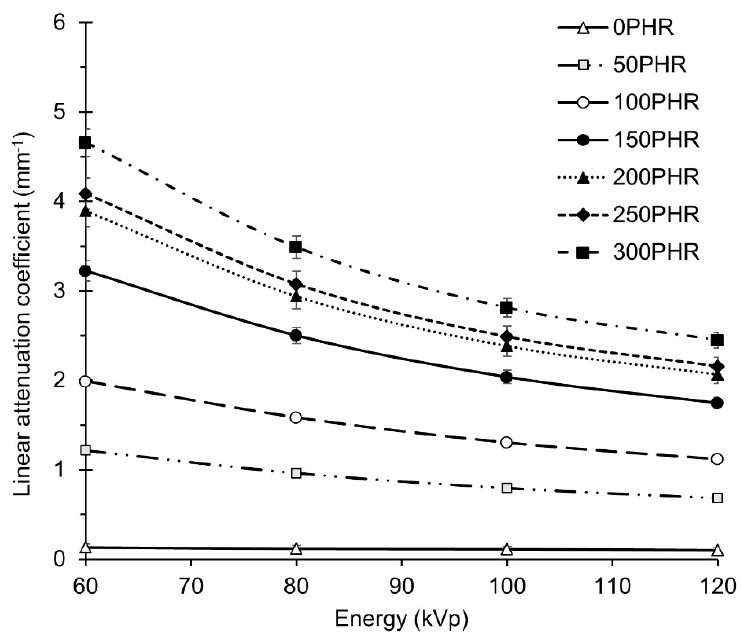
Figure 7. Linear attenuation coefficient ( µ ) at 60, 80, 100, and 120 kVp of GNRL films with 0, 50, 100, 150, 200, 250, and 300 PHR micro-Bi 2 O 3 . Results are expressed as means ( n = 15) ± 1 s.d. Table 5. Brand, thickness, attenuation efficiency (AE), and material of the radiation attenuation gloves on the market that are lead-free. Latex-free gloves are made of synthetic elastomers. AE is compared to the radiation-attenuating glove standard ASTM D7866 [50]